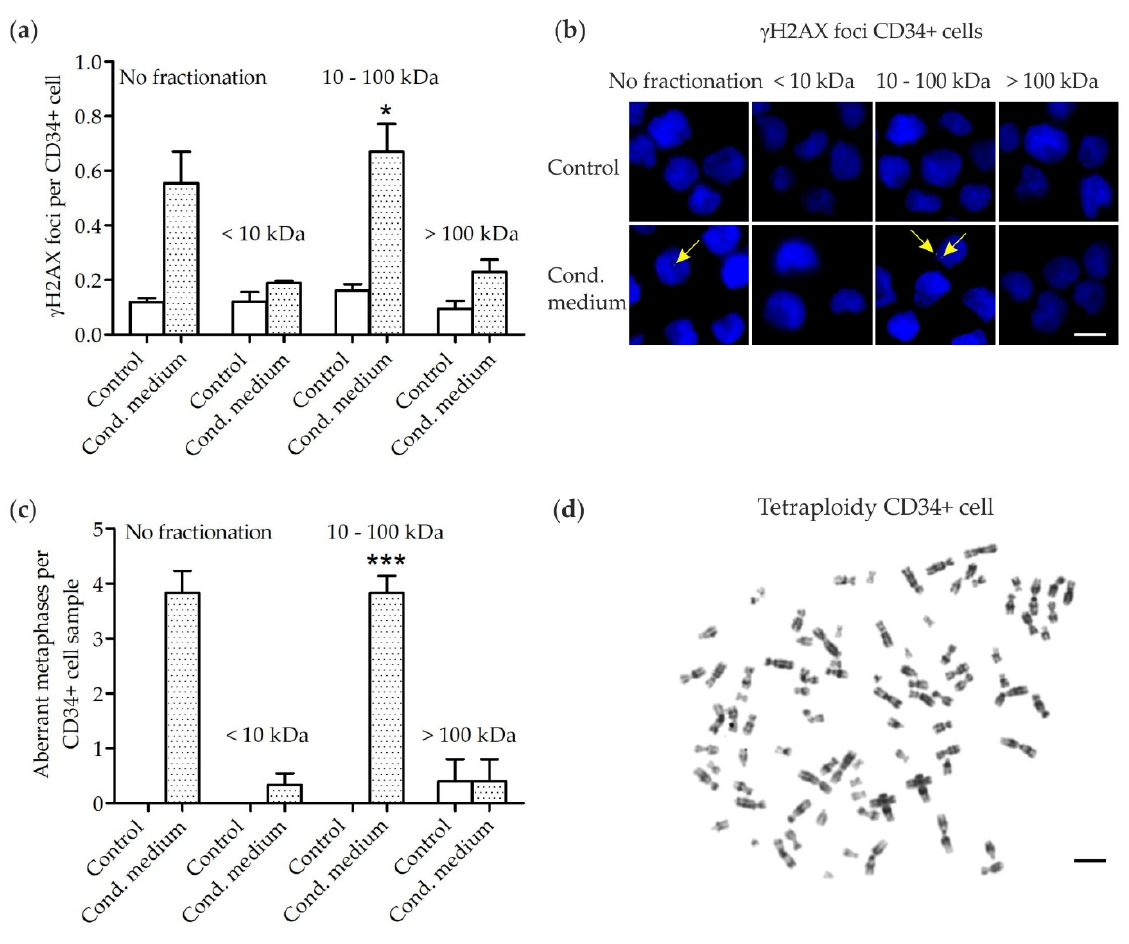
Figure 1. Radiation-induced bystander effects in CD34+ cells grown for 3 days in distinct molecular size fractions of medium conditioned by 2 Gy irradiated mesenchymal stromal cells (MSC) and un-/fractionated control medium. ( a ) γH2AX foci levels in CD34+ cells grown in (I) < 10 kDa, (II) 10–100 kDa and (III) > 100 kDa fractions of MSC conditioned medium and in un-/fractionated control medium. * p = 0.0068 (Kruskal-Wallis test) and p = 0.0286 (Wilcoxon two-sample test) when compared to numbers of γH2AX foci in CD34+ cells grown in (I) < 10 kDa and (III) > 100 kDa fractions or in un-/fractionated control medium. ( b ) Exemplary images of γH2AX foci (green, Alexa-488) in nuclei (blue, DAPI) of CD34+ cells of patient #2. Scale bar, 5 µm. ( c ) Number of aberrant metaphases in CD34+ cells grown in (I) < 10 kDa, (II) 10–100 kDa and (III) > 100 kDa fractions of MSC conditioned medium and in un-/fractionated control medium. *** p = 0.0007 (Kruskal–Wallis test) and p = 0.0022 (Wilcoxon two-sample test) when compared to number of aberrant metaphases in CD34+ cells grown in (I) < 10 kDa and (III) > 100 kDa fractions or in un-/fractionated control medium. ( d ) Exemplary tetraploidy of a CD34+ cell grown in the (II) 10–100 kDa fraction of MSC conditioned medium. Scale bar, 10 µm.